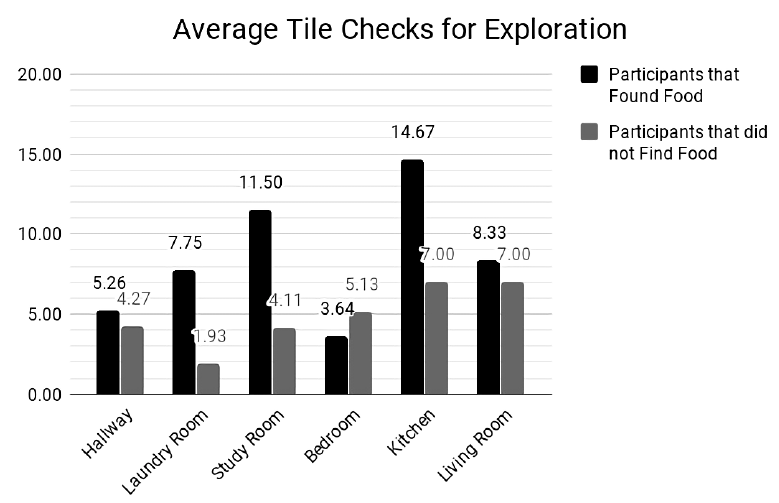
Figure 8. Average number of tile checks performed during exploration mode.